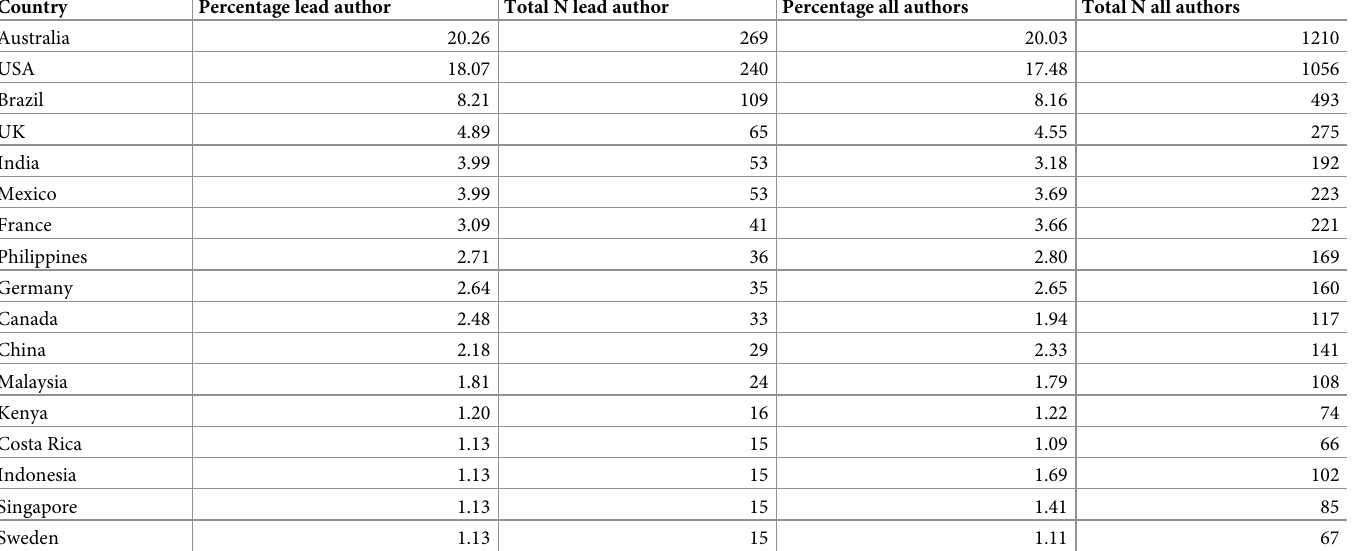
Table 3. Total number of first author and total authors per country. Only countries with more than 1%, all other countries are below 1% in both percentage lead author and all authors. Full table in S1